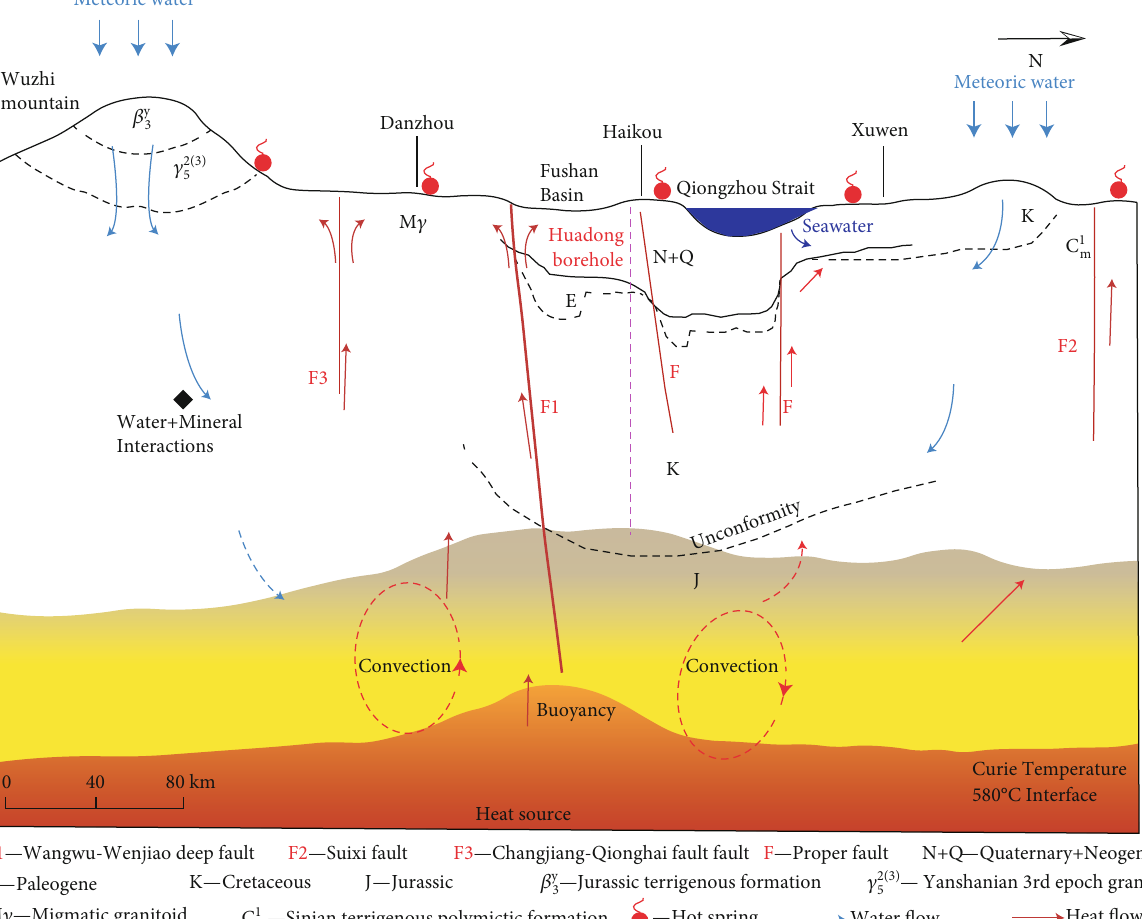
Figure 12: Conceptual model of hydrothermal system in Leizhou Peninsula and Hainan Island in South